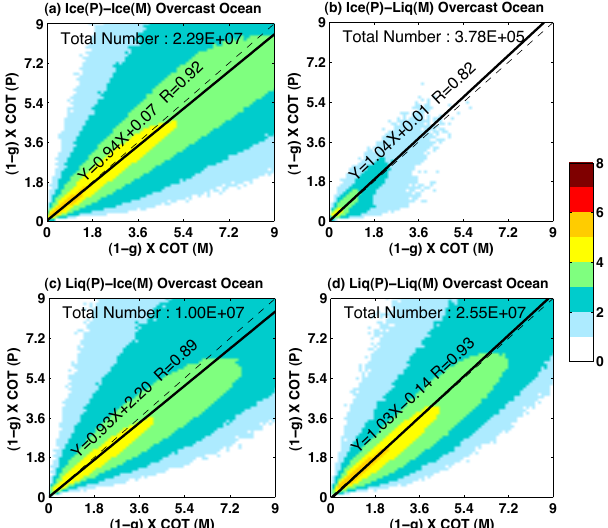
Fig. 7. Two-dimensional histograms of the product COT × ( 1 − g) for the 4 different overcast clouds over ocean separated by cloud combined phase. Color bars represent the logarithm of the pixel number. Dashed lines are the one-to-one function lines meaning the POLDER COT equal to the MODIS one. Solid lines are the com- puted linear regression functions of POLDER (y-axis) and MODIS (x-axis) scaled COT, with slopes and correlation coefficients ( R ) labeled below the solid lines. Note that figures axis are limited to upper values of 9 corresponding to COT of about 60 in Fig.